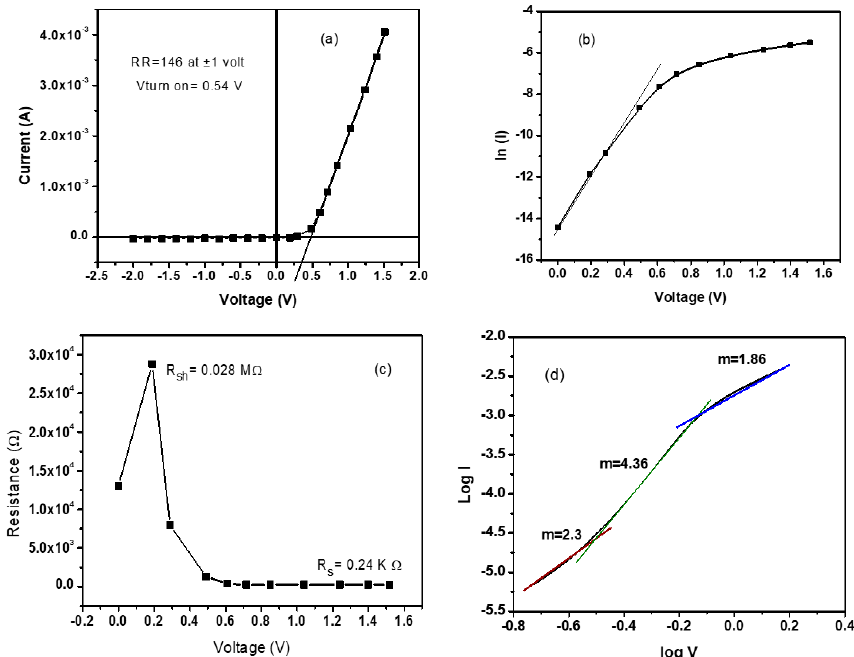
Figure 5. ( a ) I-V characteristics of Ag / ZnPc / PEDOT:PSS / ITO solar cell under dark, ( b ) semi-log I-V characteristics, ( c ) Junction resistance, Rs, versus Voltage and ( d ) log I-log V curve for ZnPc based device.